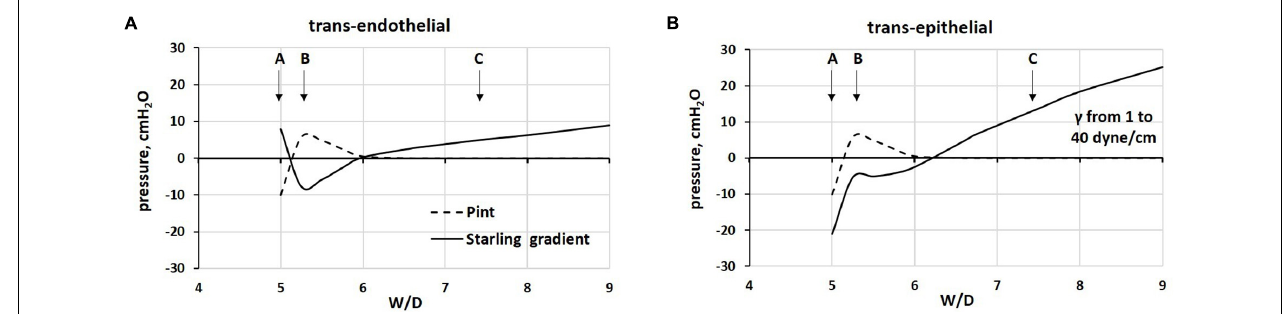
FIGURE 8 | Modeling of (A) trans-endothelial and (B) trans-epithelial Starling pressure gradients (solid line) on increasing W/D, based on experimentally measured values of interstitial pressure (Pint, dashed line), with Palv = 0 cmH 2 O. Points A, B, and C as from Figure 4 .